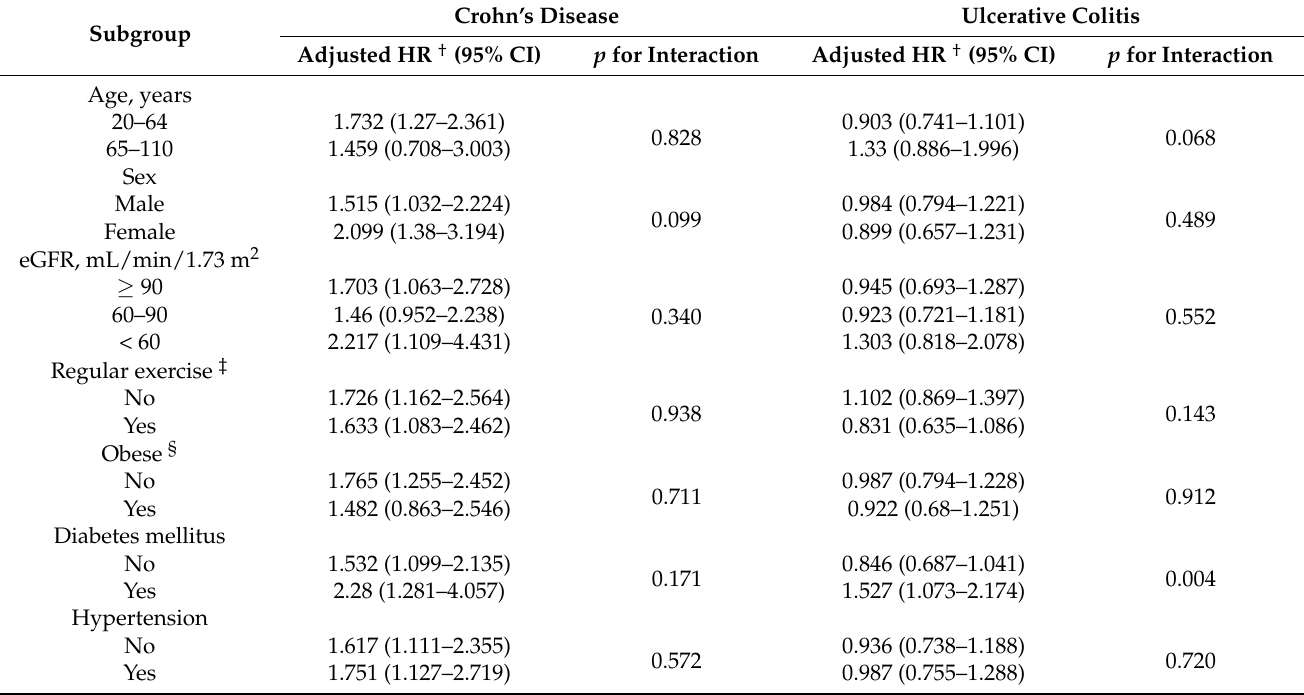
Table 3. Subgroup analysis of the risk of Crohn’s disease and ulcerative colitis among people with dipstick-positive